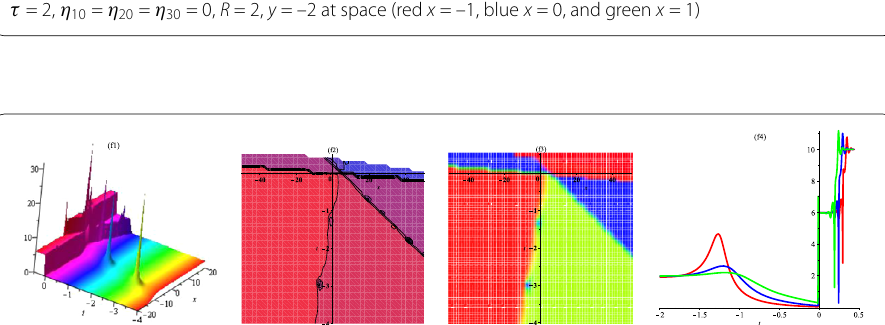
Figure 6 Diagram of 3-lump (2.20) by taking a = 1.5, b = 1, c = 2, d = 3, k 1 = 1, k 2 = 2, k 3 = 3, α = 0.1, (cid:14) = –1, τ = 2, η